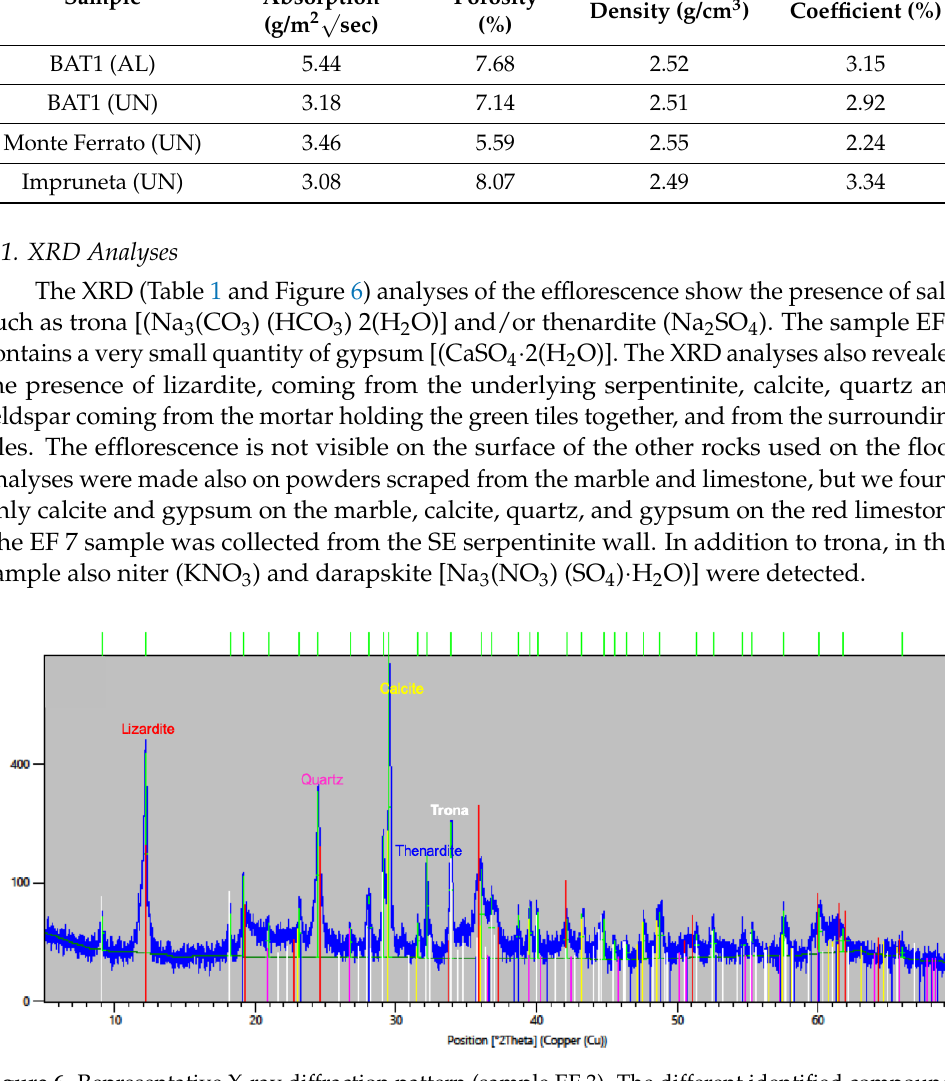
Figure 6. Representative X-ray diffraction pattern (sample EF 3). The different identified compounds are reported in correspondence with the main peaks.